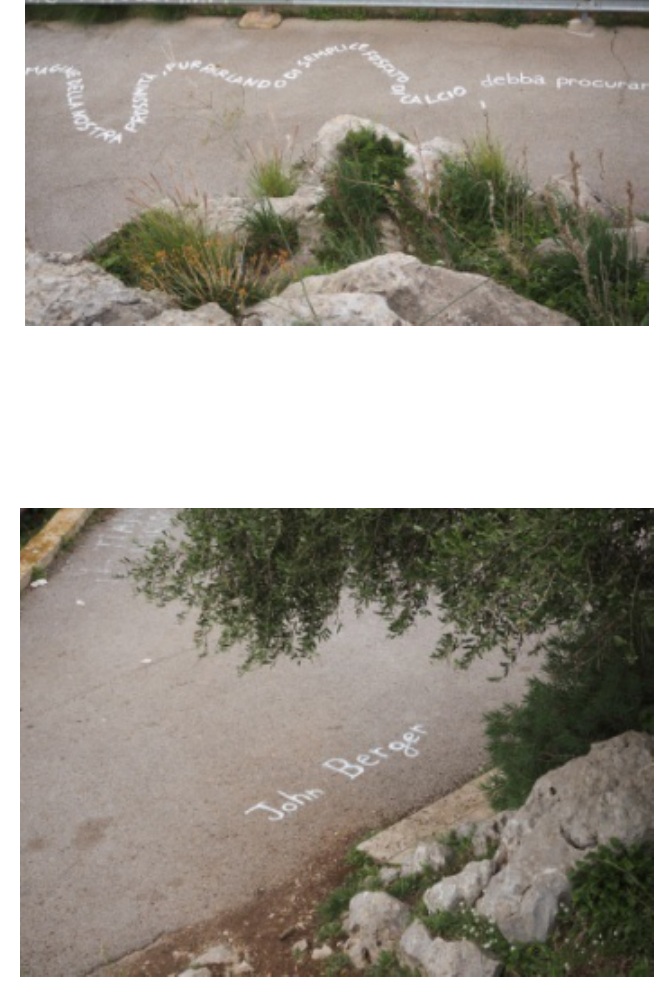
Figg. 9, 10 : Milan, 20 December